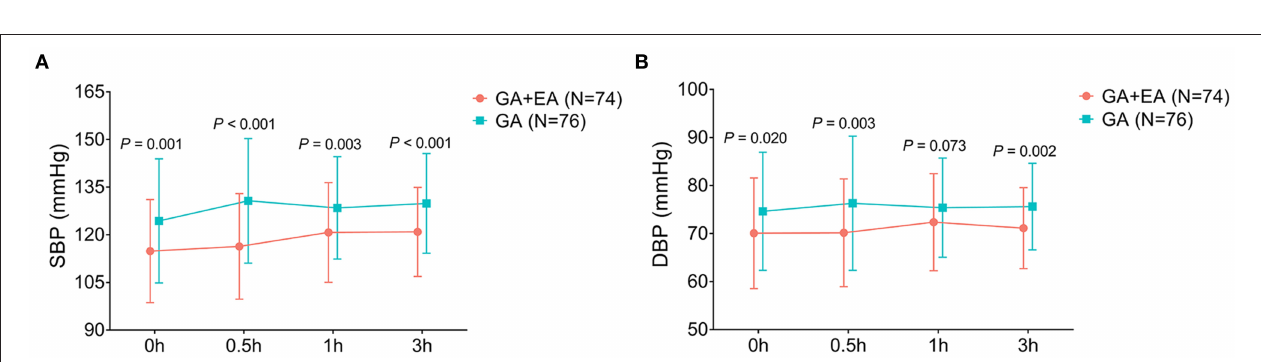
FIGURE 4 | Occurrence and severity of CRBD in patients with urinary/reproductive system-related surgeries or other surgeries. Comparison of the occurrence (A) and severity (B) of CRBD between GA + EA group and GA group in patients with urinary or reproductive system-related surgeries; Comparison of the occurrence (C) and severity (D) of CRBD between GA + EA group and GA group in patients with other surgeries. CRBD, catheter-related bladder discomfort; GA, general anesthesia; EA, epidural anesthesia; h, hour.